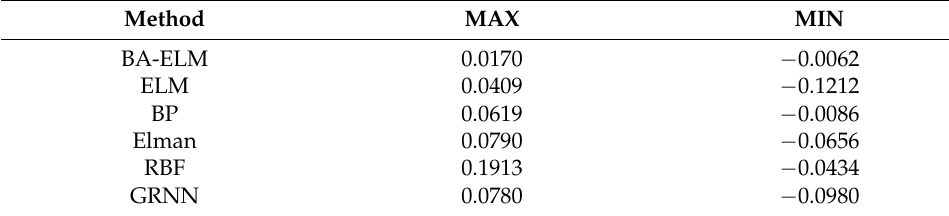
Table 7. Comprehensive comparison table of MAX and MIN.